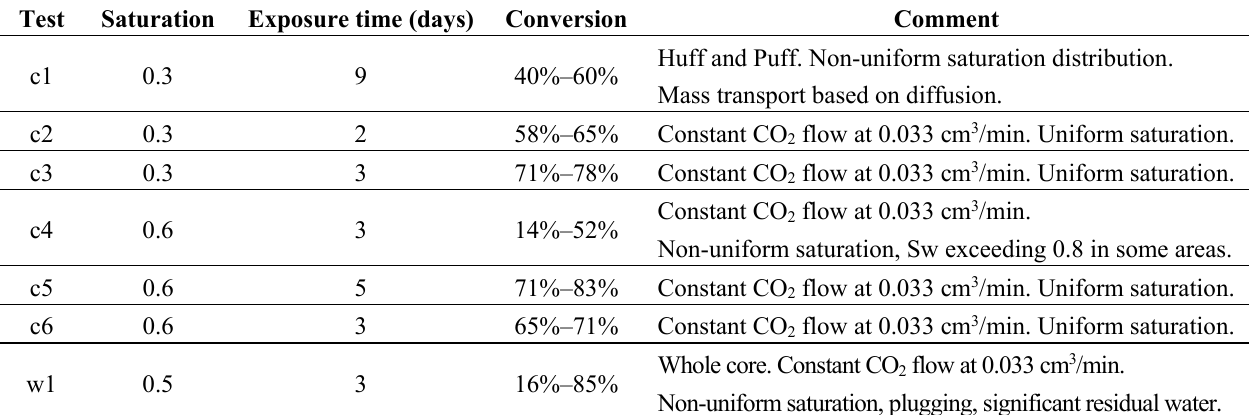
Table 2. Summary of experimental conditions and results for data illustrated in Figure 9.